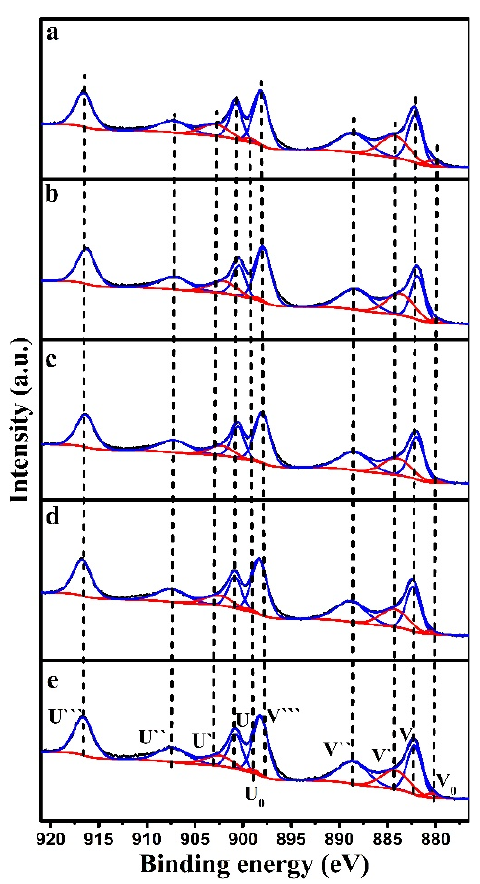
Figure 7. Ce 3d XPS spectra of the CuO/CeO 2 catalysts: ( a ) CeO 2 nr, ( b ) 10%Cu/Ce, ( c ) 20%Cu/Ce, ( d ) 50%Cu/Ce, and ( e ) 80%Cu/Ce.